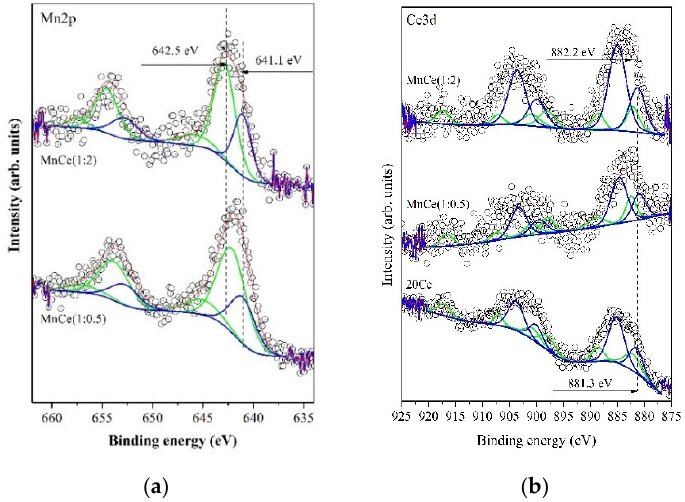
Figure 7. Fitted Mn2p ( a ) and Ce3d ( b ) photoelectron peaks of the Ce and Mn–Ce samples before reaction.